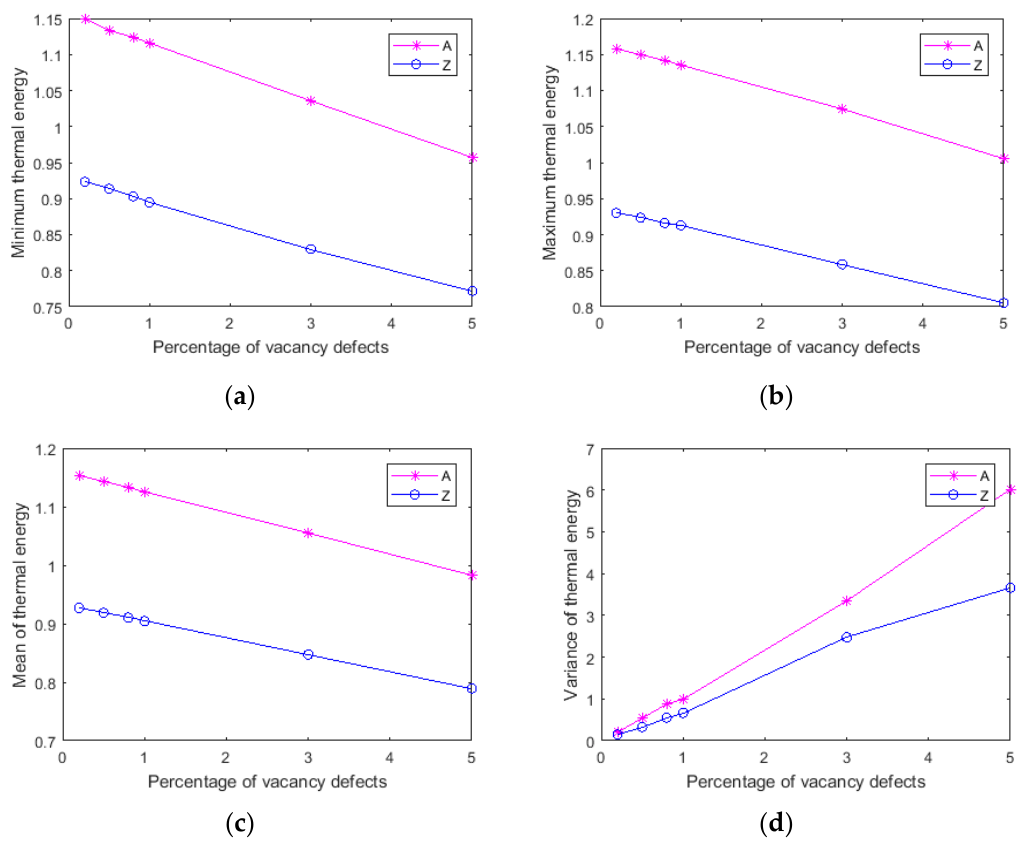
Figure 13. The statistical results of graphene with random distributed vacancy defects (the unit for thermal energy is 10 5 J; ( a – d ) are the minimum, maximum, mean, and variance values of the thermal energy, respectively.